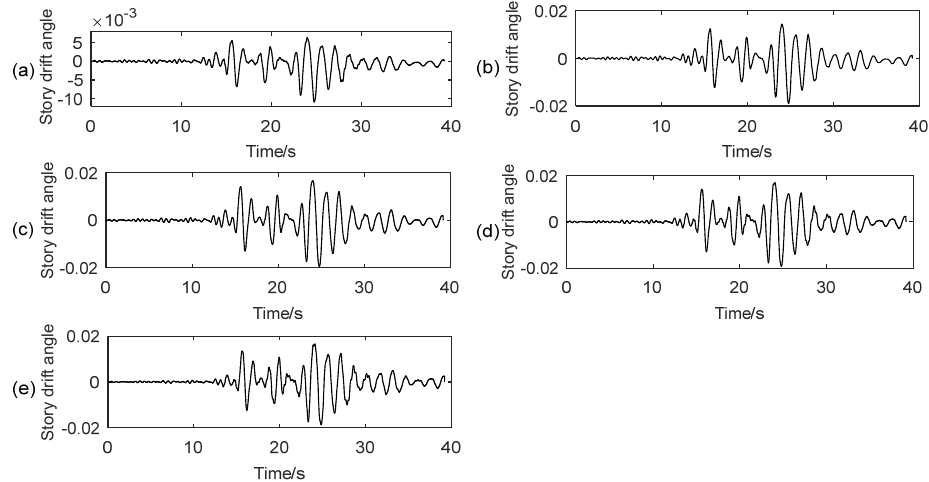
Figure 14. Story drift angle time histories of different stories under a certain seismic ground motion (rare earthquake): ( a ) first story; ( b ) second story; ( c ) third story; ( d ) fourth story; ( e ) fifth story.